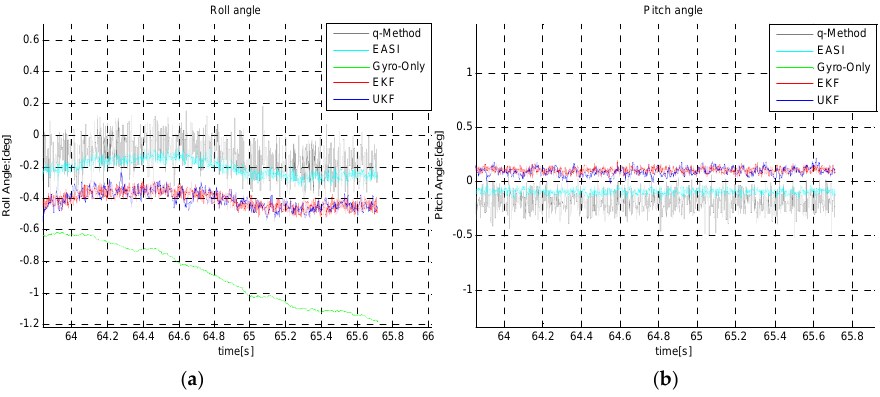
Figure 20. End trajectory Roll angle ( a ) and pitch angle ( b ) estimation during long time dynamic test. Table 6. Statistical comparison of estimated tilt angles in the long ‐ time dynamic test.